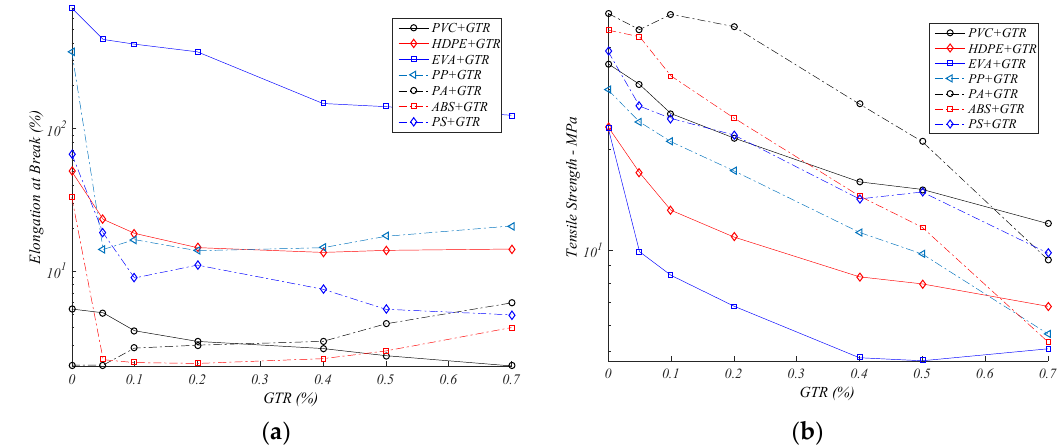
Figure 1. ( a ) Elongation at break (%), ( b ) tensile strength (MPa), for seven polymers / ground tire rubber (GTR) concentrations with a particle size <200 µm.